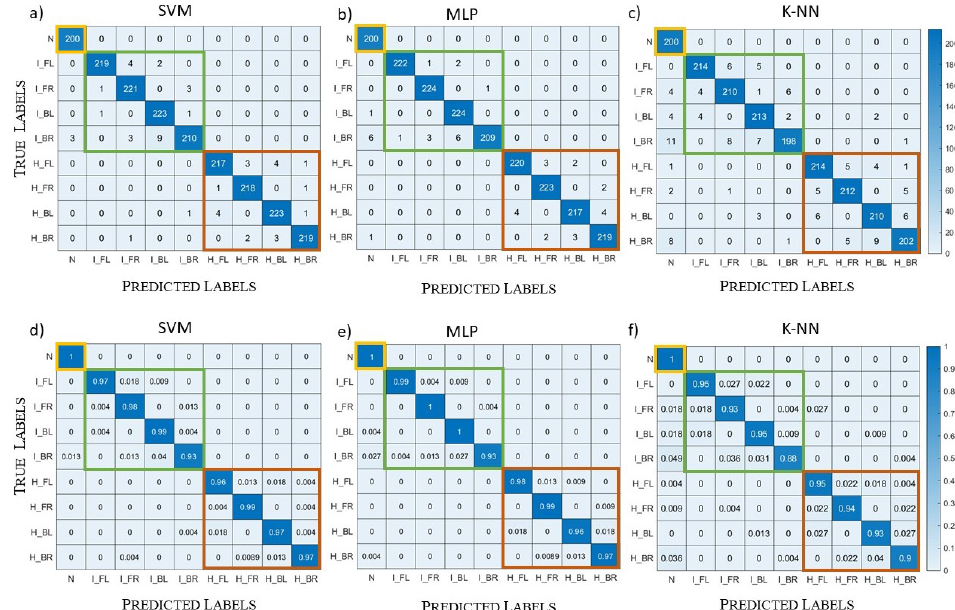
Figure 11. Validation case, complex datasets: ( a – c ) confusion matrices; ( d – f ) normalized confusion matrices; ( a , d ) SVM results; ( b , e ) MLP results; ( c , f ) k-NN results.